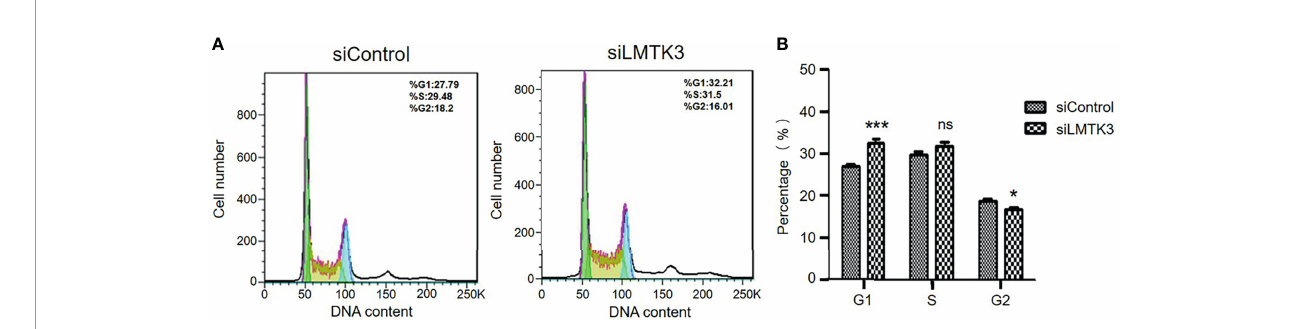
FIGURE 3 | Effects of LMTK3 knockdown on cell cycle arrest in Ishikawa cells by fl ow cytometry. (A) Representative diagrams of LMTK3 knockdown on cell cycle arrest in Ishikawa cells. (B) Statistical histogram of LMTK3 knockdown on cell cycle arrest in Ishikawa (n=3, * P < 0.05, *** P < 0.001). ns represents no statistical signi fi cance).